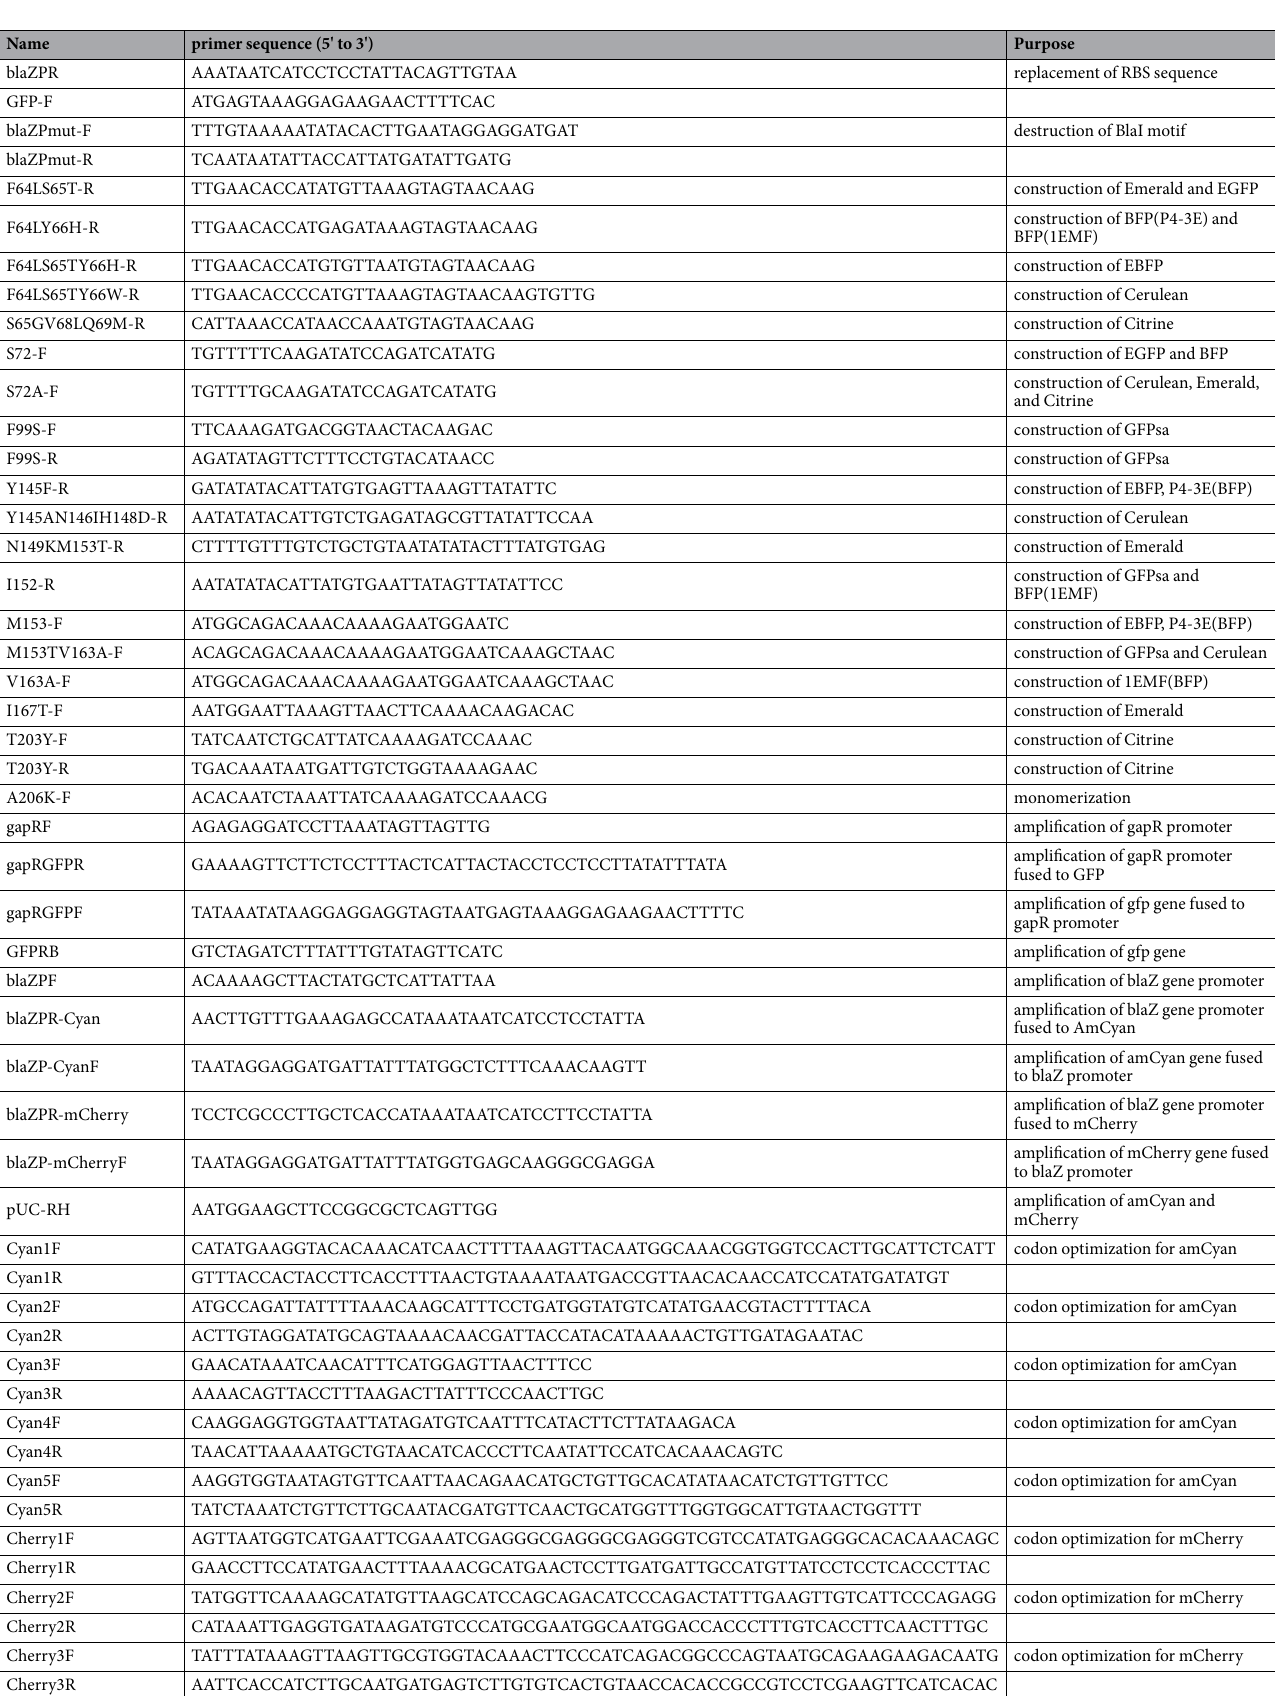
Table 2. Oligonucleotide